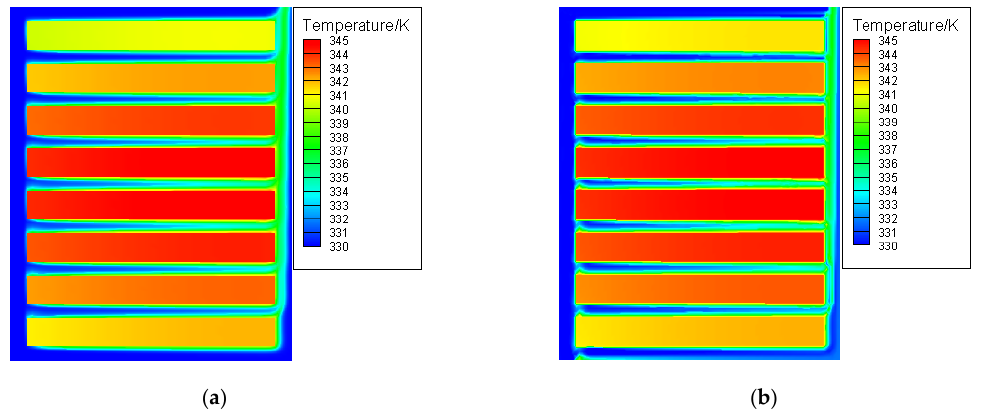
Figure 5. Temperature distribution contour: ( a ) calculation result by Fluent; ( b ) calculation result by the upwind finite element method.